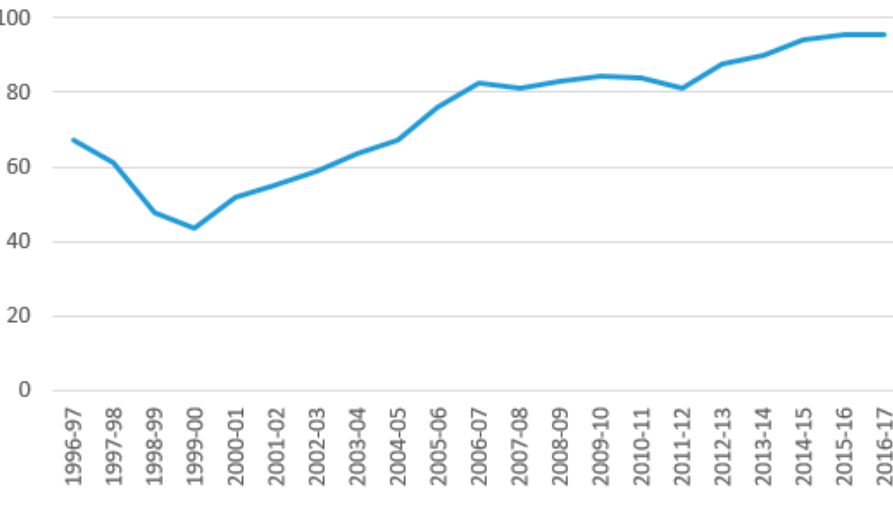
Figure 1. Degree of self-sufficiency of Brown Cattle sperm in